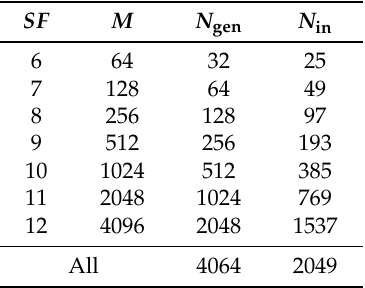
Table 2. N gen and N in for a LoRa system with chirp segmentation.